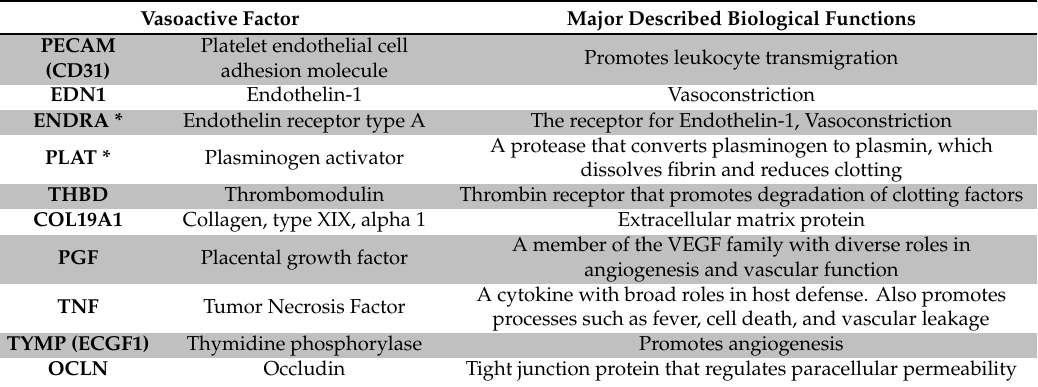
Table 1. Vascular functions of products with increased expression in HuMEC cells in response to DENV-activated huMCs.